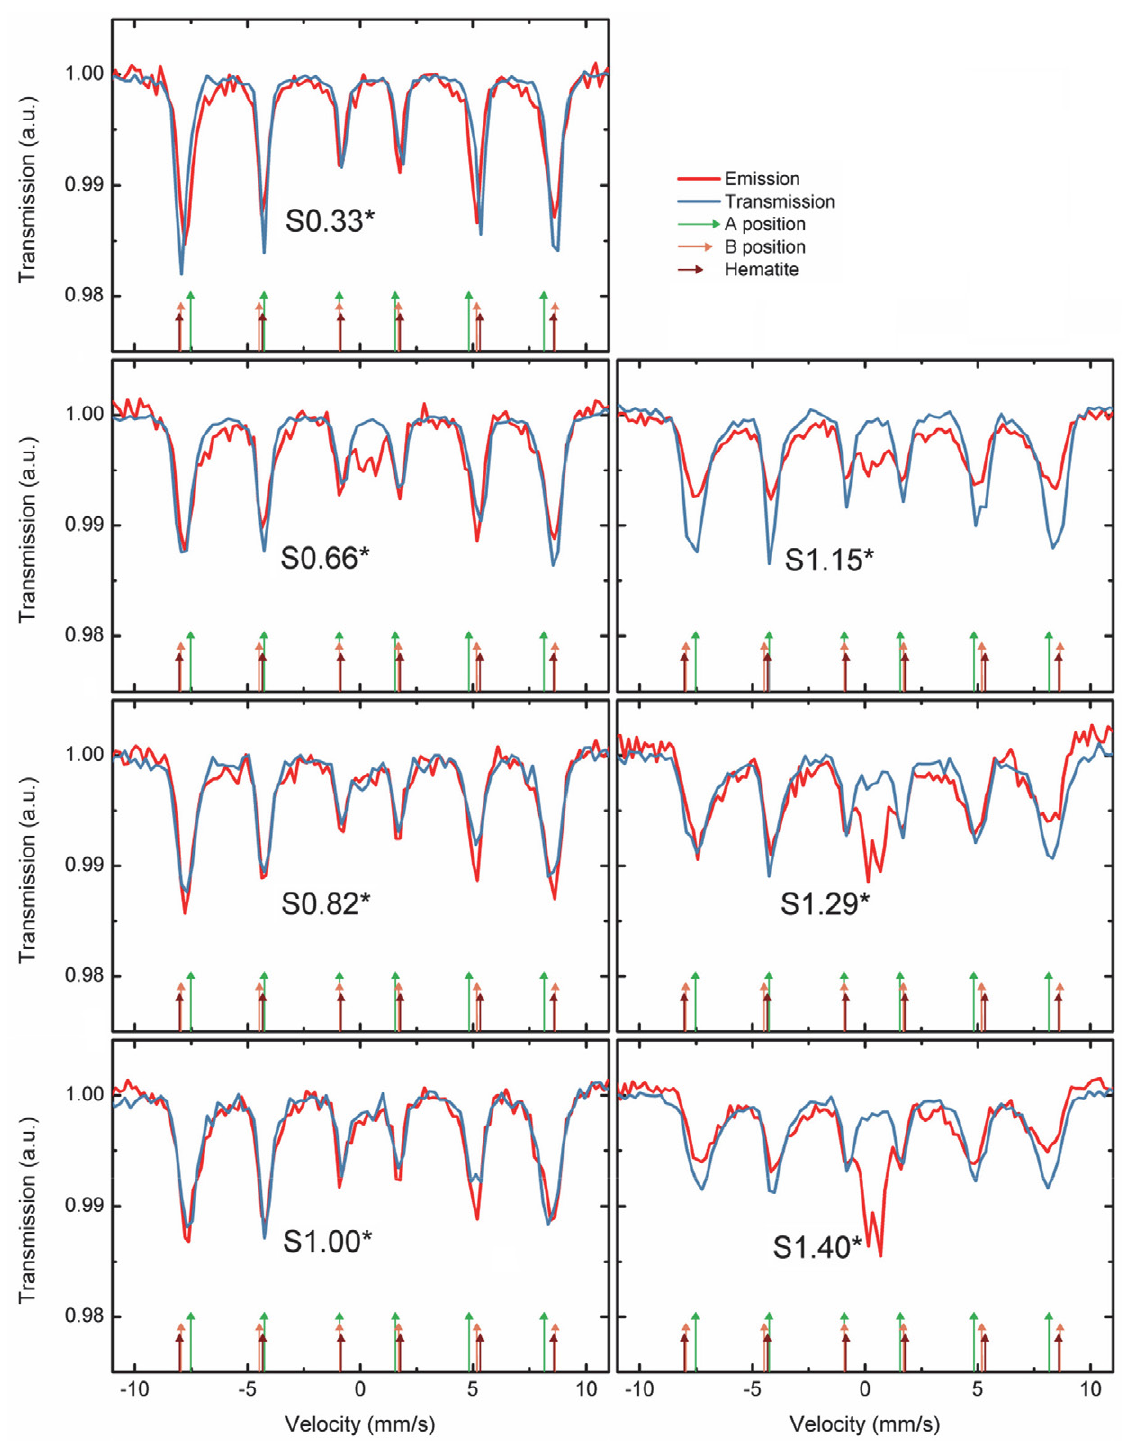
Figure 5. Emission and transmission spectra of samples S0.33*, S0.66*, S0.82*, S1.00*, S1.15*, S1.29* and S1.40*. The arrows indicate the lines posi- tions of CoFe 2 O 4 (A and B positions) and Fe 2 O 3